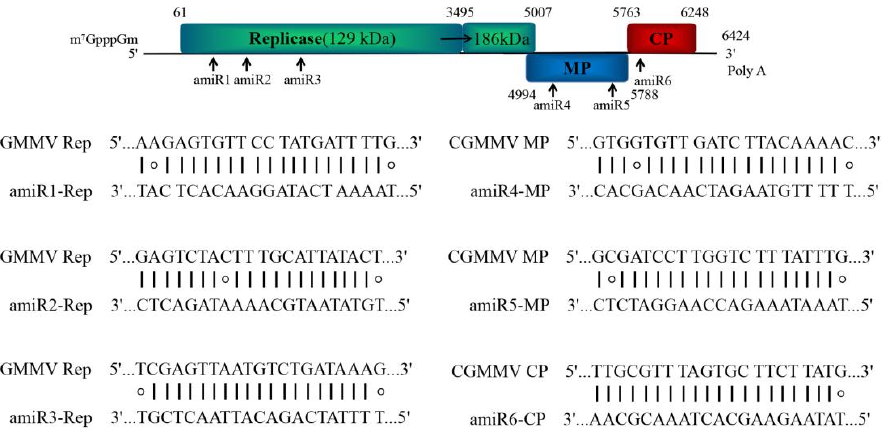
Figure 2. Schematic diagram of amiRNA designed for silencing the CGMMV genes coding for replicase proteins, movement protein (MP), and coat protein (CP). amiRNA, artificial microRNA; CGMMV, cucumber green mottle mosaic virus.